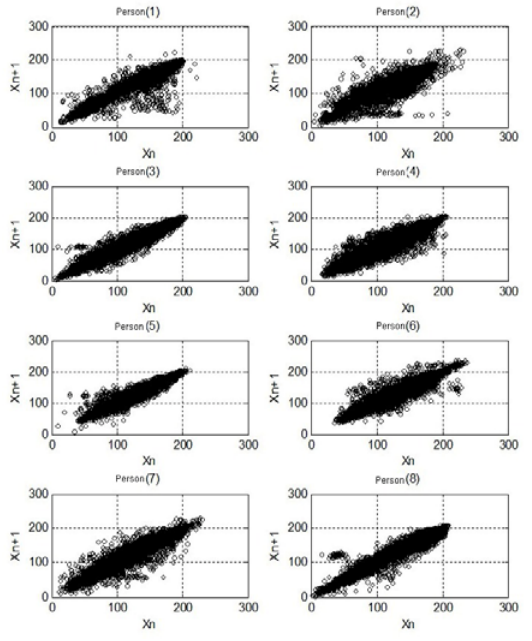
Fig. 8: State space point distribution graphs of eight instances of face image of the given person in AT & T face